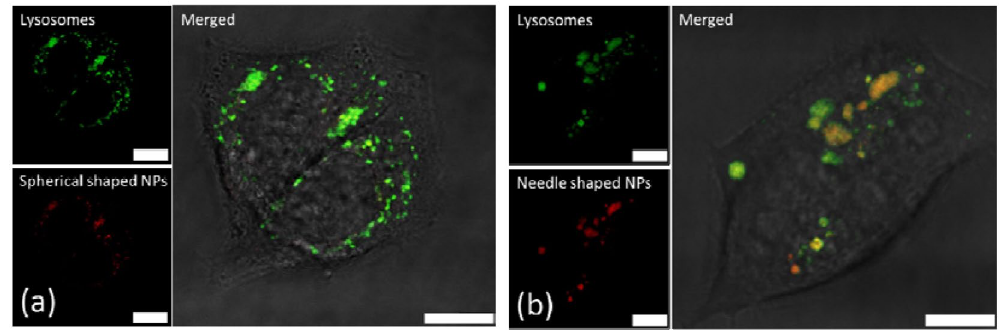
Figure 3. Shape dependent PLGA-PEG NPs intracellular distribution. Confocal images of cellular uptake of ( a ) spherical- and ( b ) needle-shaped NPs at 50 µ g/mL by HepG2 cells for 24 hours. (Green: Lysosomes, Red: NPs, Yellow: overlaid. Scale bar: 10 µ